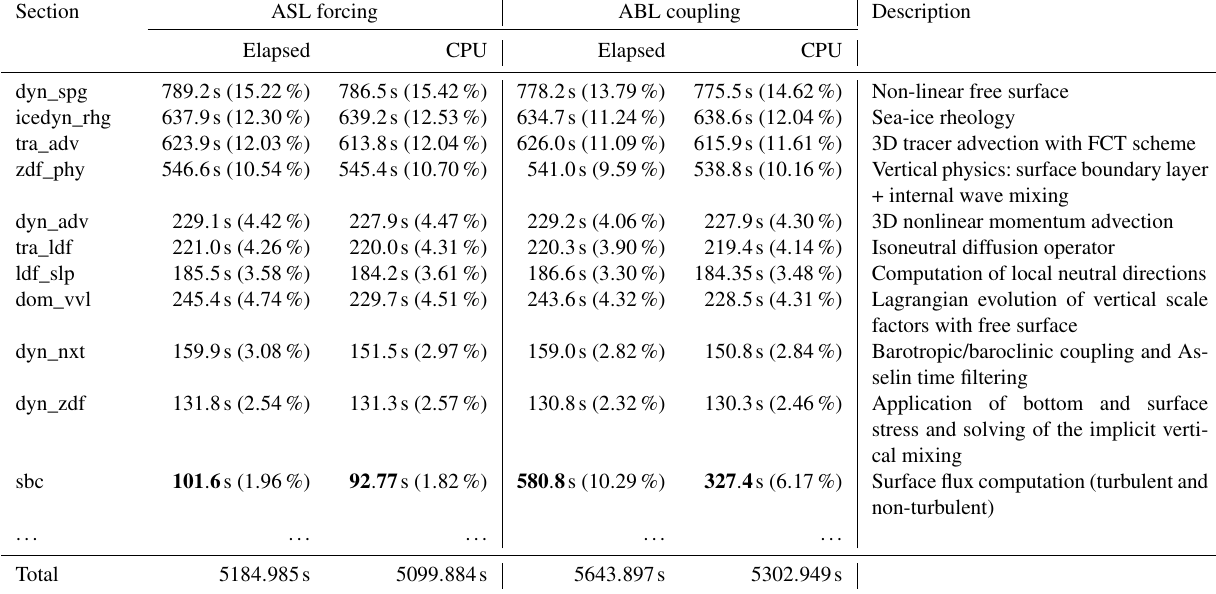
Table D1. Report of the elapsed time and CPU time in different sections of the NEMO (v4.0) code for the ASL forcing strategy (left portion of the table) and the ABL coupling strategy (right portion of the table). The timing is averaged on all processors. The right-most column provides a quick description of the task handled by the corresponding section. On top of the timing in seconds the percentage of the total CPU and elapsed time associated with each section is reported in parentheses. The computational overhead associated with the ABL coupling strategy can be estimated from the sbc section and the elapsed and CPU